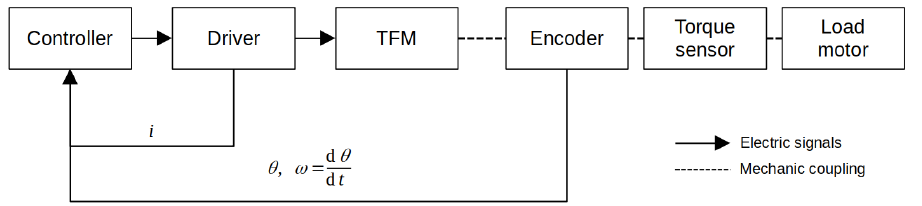
Figure 20. Basic FOC control